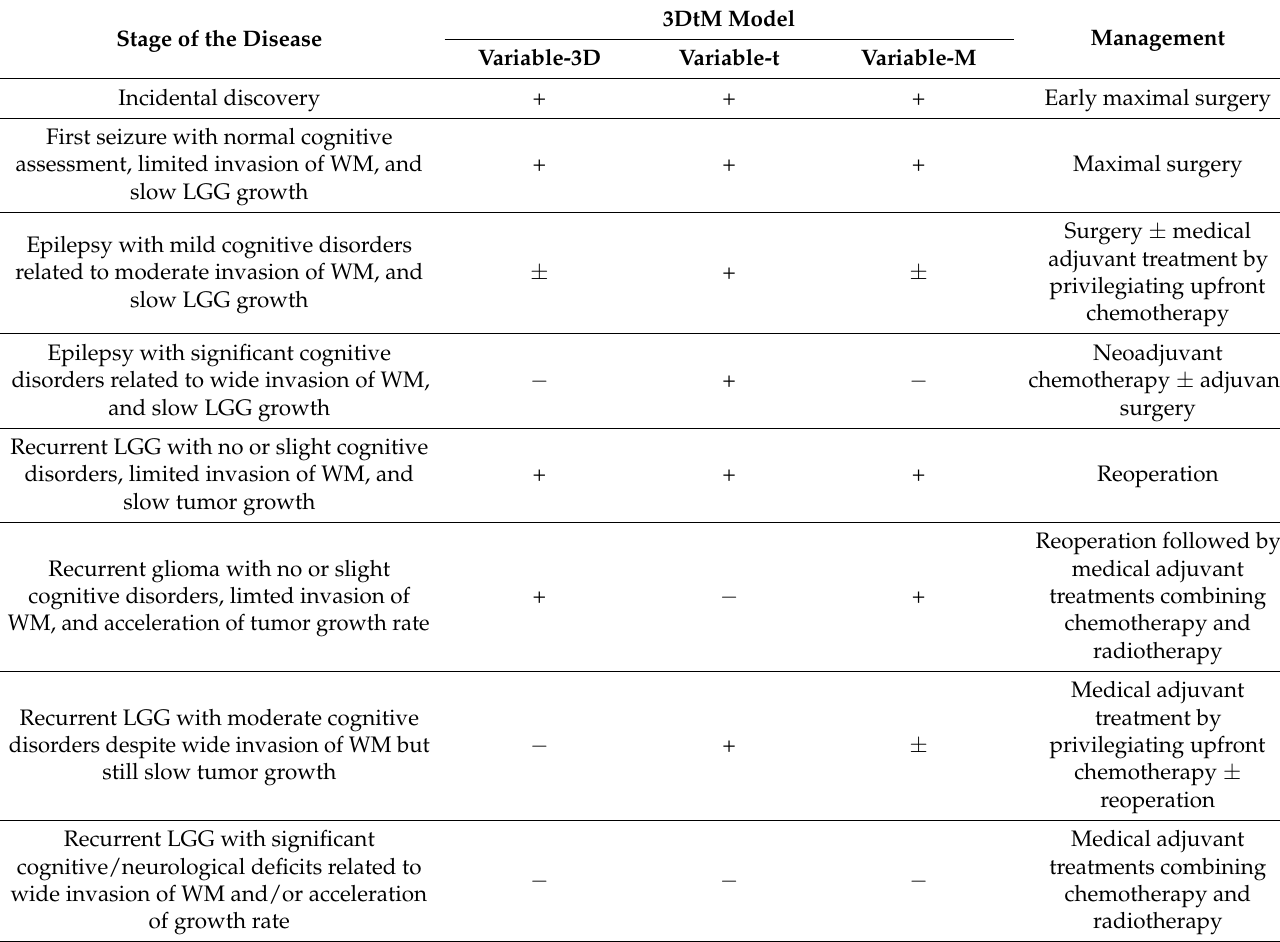
Table 1. Clinical therapeutic approach based upon the 3DtM